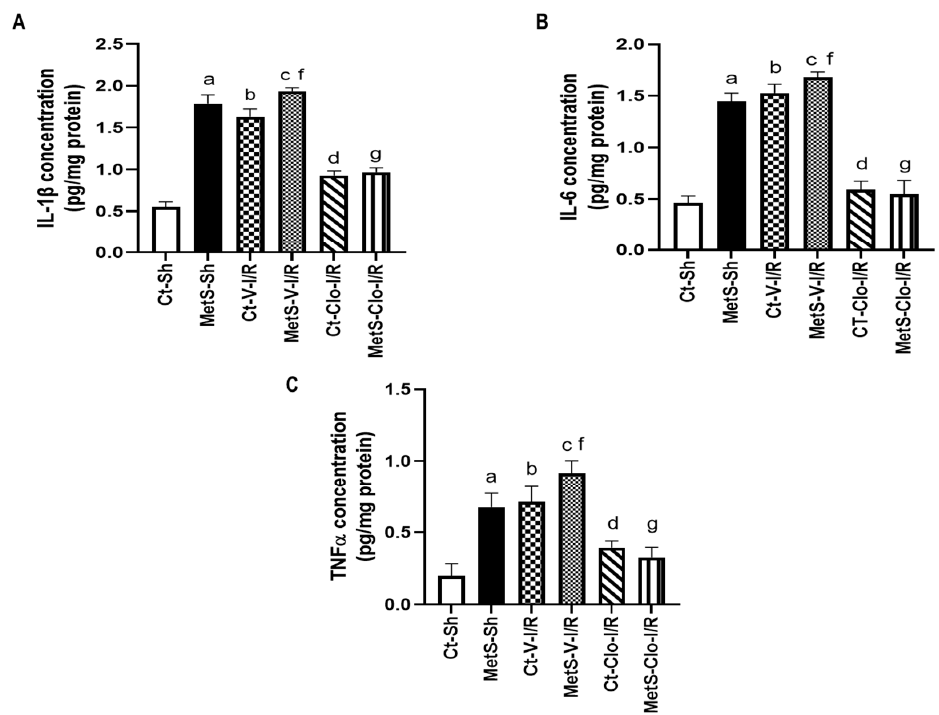
Figure 1. Effect of PPAR α agonist clofibrate in the production of pro-inflammatory interleukins that are induced by ischemia/reperfusion injury in hearts from metabolic syndrome rats. ( A ) IL-1 β , ( B ) IL-6, and ( C ) TNF- α concentration in left ventricles from control and MetS rats. Data represent mean ± SEM (n = 6 per group). a p < 0.0001 vs. Ct-Sh; b p < 0.0001 vs. Ct-Sh; c p < 0.0001 vs. Ct-V-I/R; d p < 0.0001 vs. Ct-V-I/R; f p < 0.0001 vs. MetS-Sh; g p < 0.0001 vs. MetS-V-I/R. Abbreviations: Ct = control; MetS = metabolic syndrome; Sh = sham-operated rats; V = vehicle; Clo =